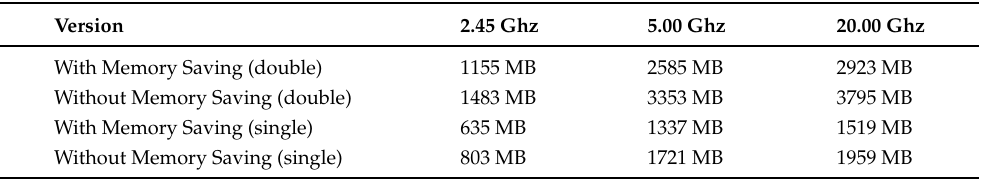
Table 4. Used memory for each scenario in the free space propagation, with and without memory saving and using single and double precision.